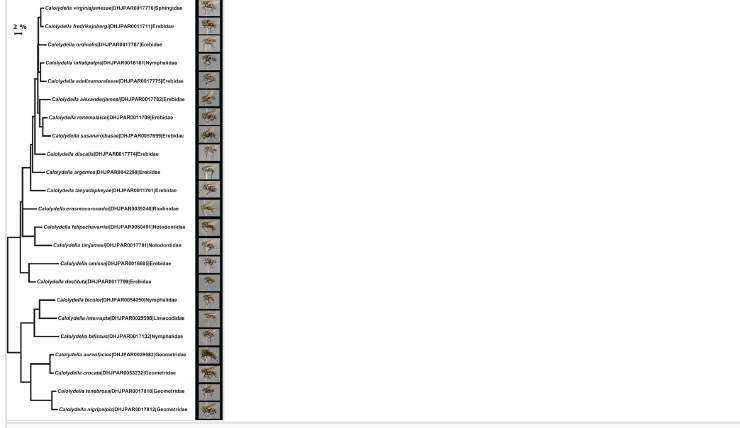
Figure 39. Maximum Likelihood tree showing DNA barcode variation within ACG species of Calolydella . The inter- and intra-specific variation within the DNA barcode region for the 23 species of Calolydella from ACG is illustrated using a Maximum Likelihood tree based on the General Time Reversible model (GTR) (Nei and Kumar 2000). GTR was selected due to the lowest BIC scores (Bayesian Information Criterion) of the Maximum Likelihood fits of 23 different nucleotide substitution models run in MEGA6 (Tamura et al. 2013). Tip labels include species name|specimen code|host family of each species. A habitus image in lateral view of each holotype is presented with the